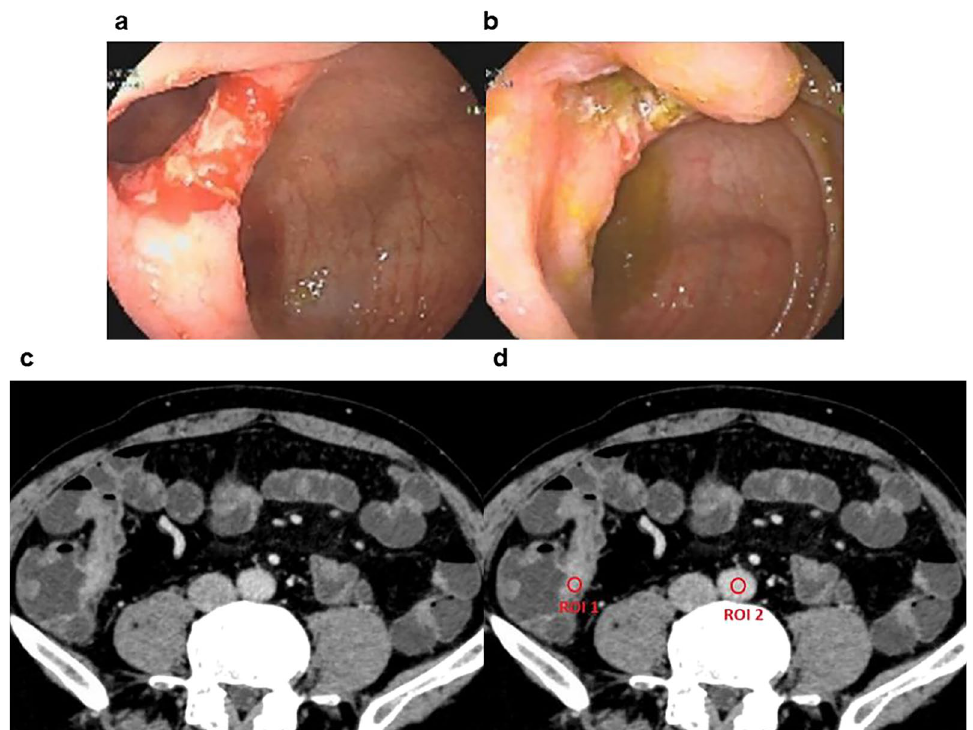
Fig. 4 A 52-year-old man with Crohn’s disease did not achieve endoscopic mucosal healing after 8 months of therapy. a Endoscopic images of the terminal ileum show ulcerating inflammation before infliximab treatment. b Posttreatment endoscopic images still show ulcerating inflammation. c On the posttreatment enteric phase axial CTE image, the wall of the terminal ileum is thickened. d ROI1 was placed in the thickened wall of the terminal ileum in these iodine-based material decomposition images, and ROI2 was placed in the artery at the same level. The NIC in this thickened